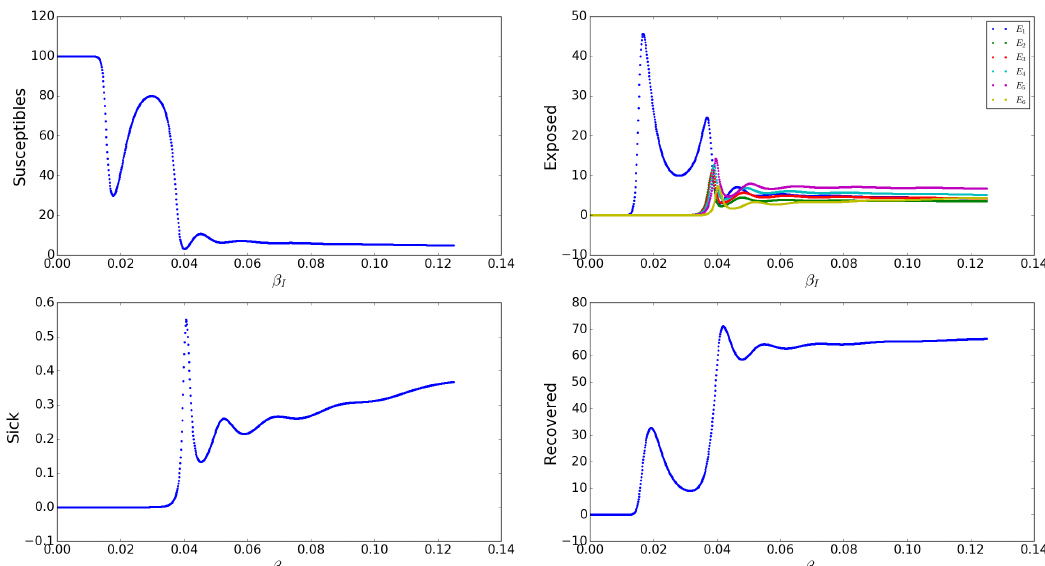
(cid:48) s (represented here by β I as i